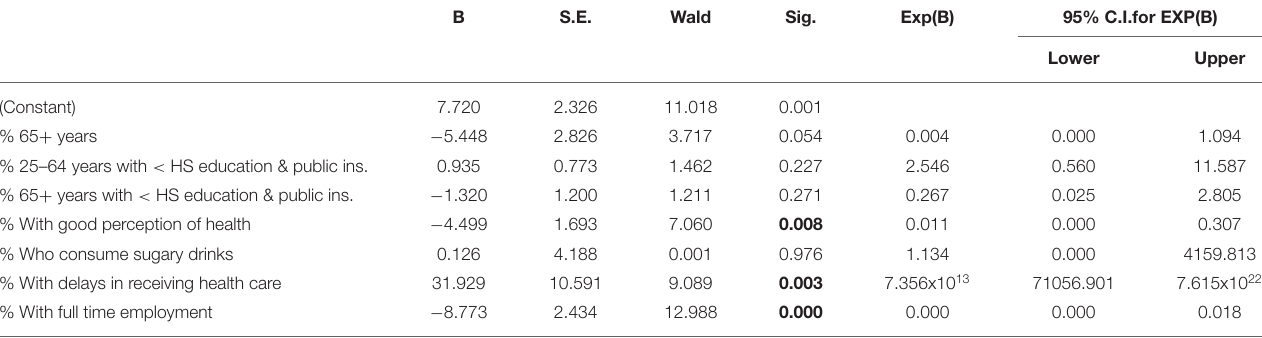
TABLE 5 | Results of binary logistic regression model (Pseudo R-square = 0.414, n =